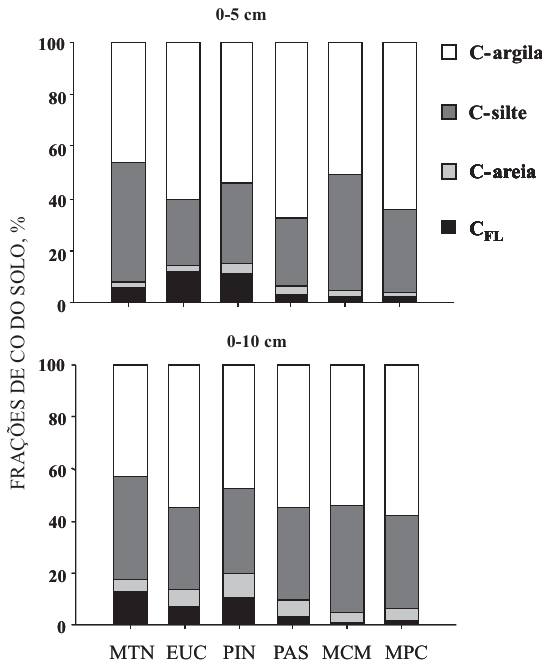
Figura 2. Percentagem do carbono orgânico nas frações leve (C ) e pesada (C-areia, C-silte e C- FL argila) nas profundidades de 0–5 e 0–10 cm de Latossolo Vermelho distroférrico típico submetido a diferentes sistemas de uso e manejo. MTN: mata nativa; EUC: eucalipto; PIN: pinus; PAS: pastagem; MCM: milho no sistema de cultivo mínimo; MPC: milho no sistema plantio